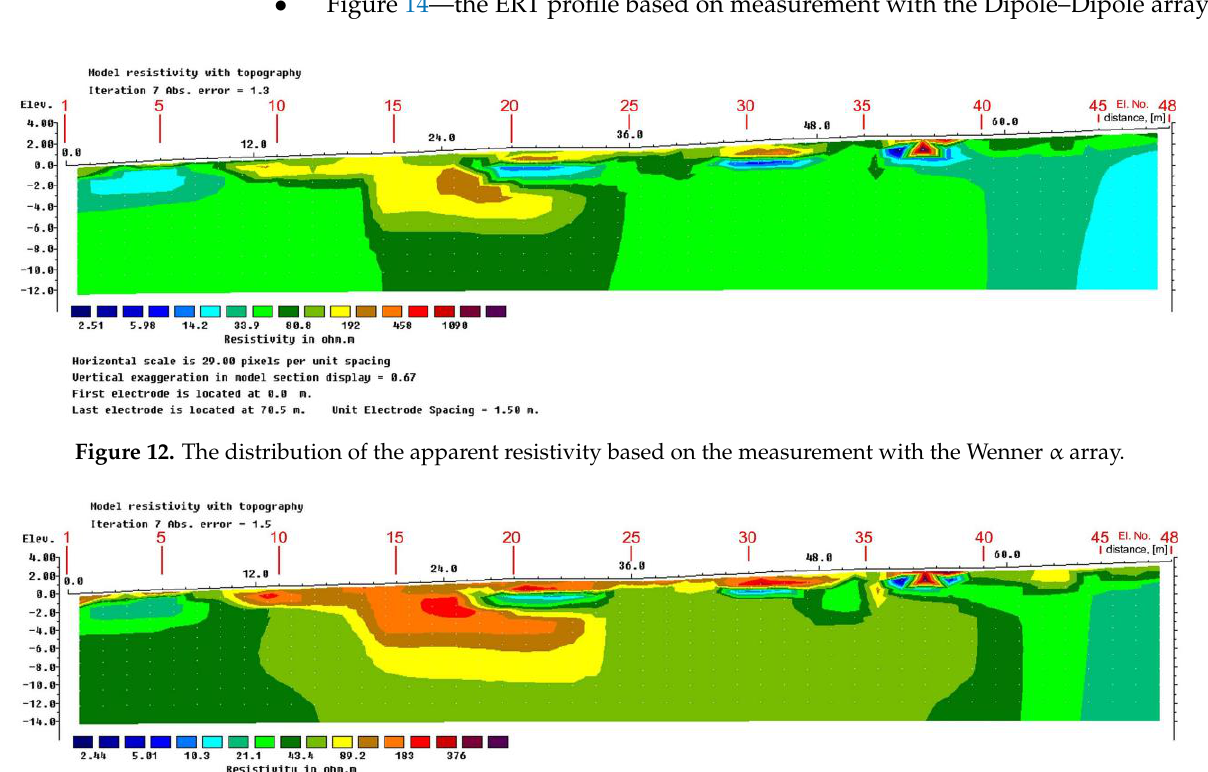
Energies 2021 , 14 , x FOR PEER REVIEW 11 of 16